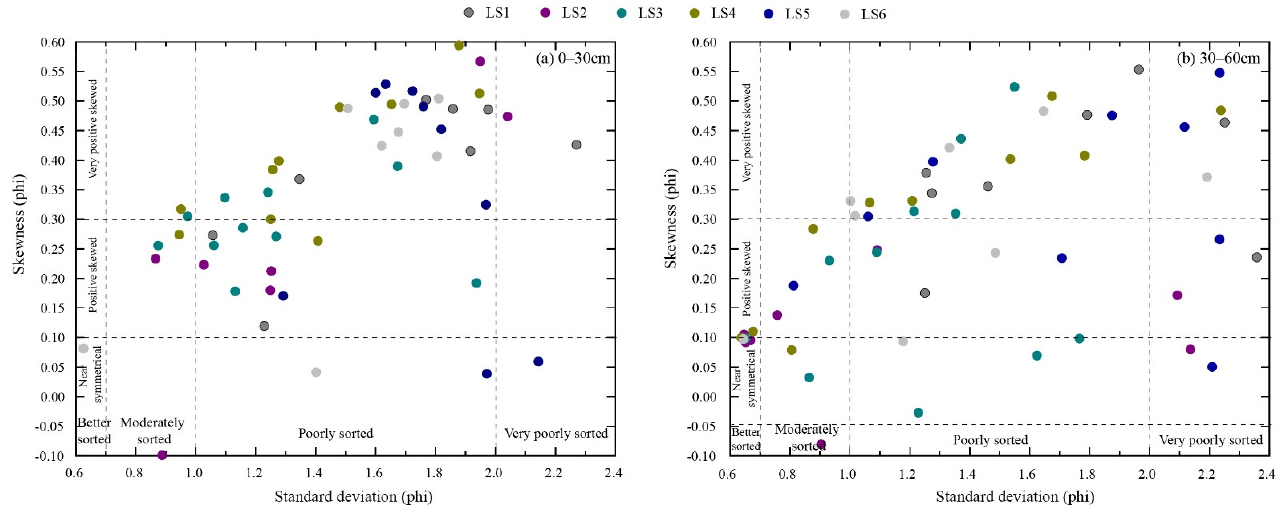
Figure 7. Correlations between the standard deviation ( σ I ) and the skewness (SK I ) of the sediments collected from different